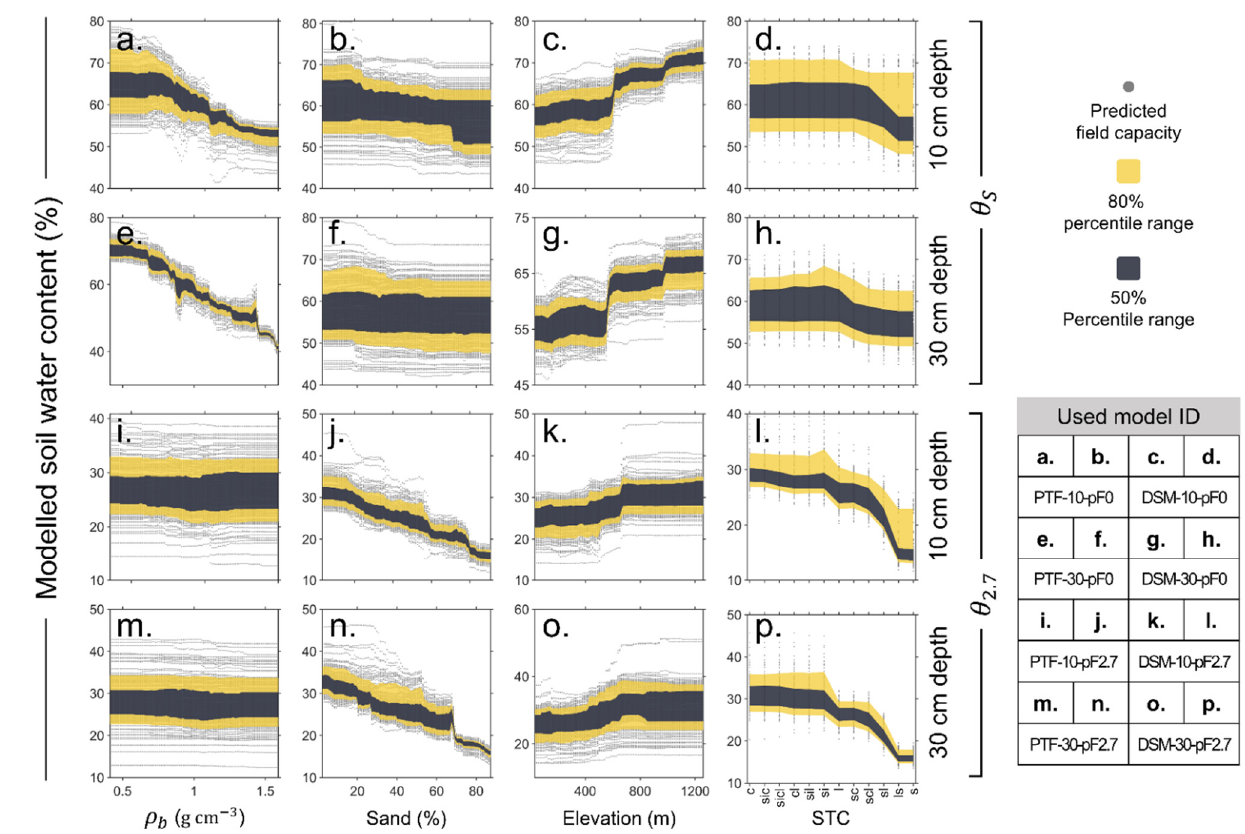
Figure 5. Non-linear changes in modelled soil water content by sensitivity analysis. Modelled soil water content changes of ( a – d ) θ S at 10 cm depth soil, ( e – h ) θ S at 30 cm depth soil, ( i – l ) θ 2.7 at 10 cm depth soil, ( m – p ) θ 2.7 at 30 cm depth soil were represented with four variables: bulk density, sand fraction, elevation, and soil texture class.